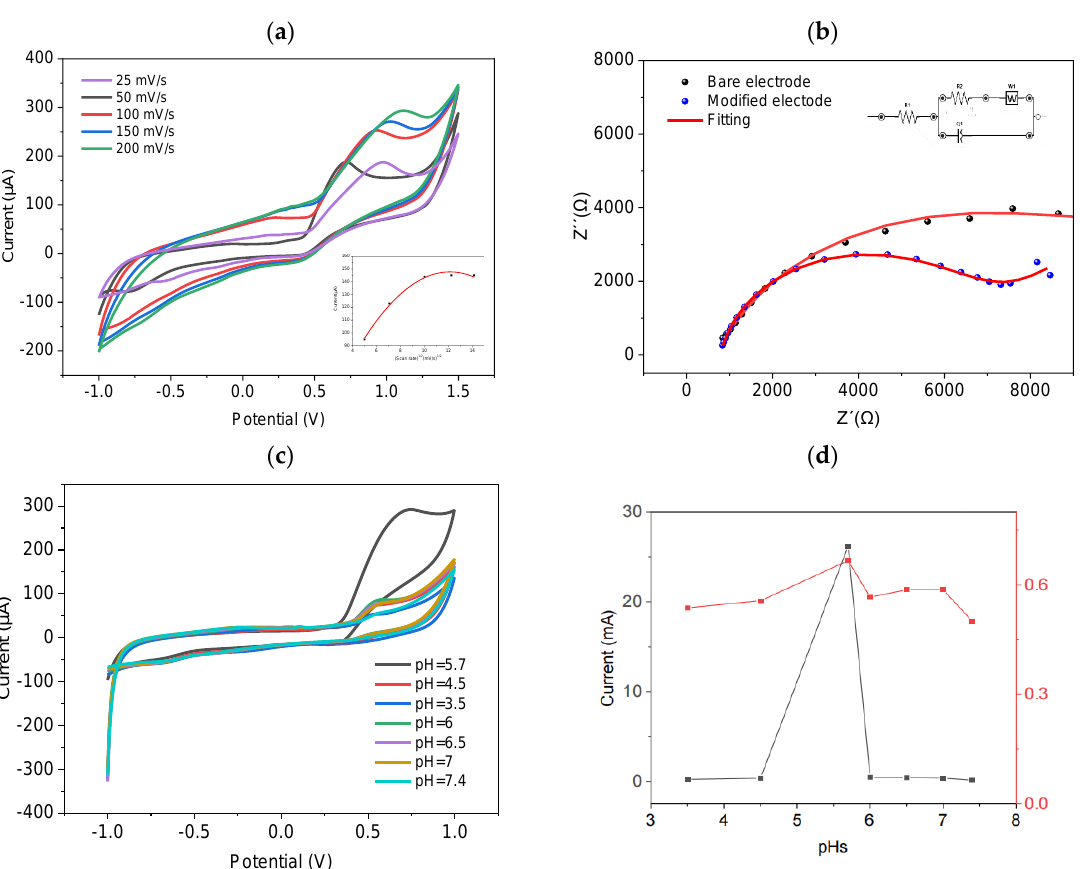
Figure 10. ( a ) Cyclic voltammetry in a PBS solution with different scan rates values and fixed 10 − 4 M of NO 2 − . ( b ) Nyquist plots of the bare and modified electrodes; inset: equivalent circuit. ( c ) Cyclic voltammograms of detection of NO 2 − indifferent pHs. ( d ) Adjustment of the current and potential according to the pH of the solution.